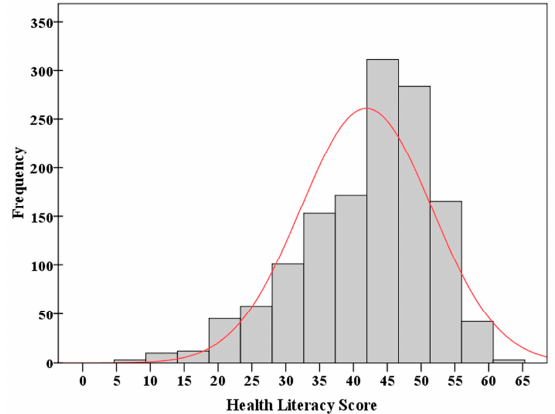
Figure 2. Histogram of the health literacy scores obtained from 1360 participants. The curve represents a normal curve with the mean and standard deviation estimated from the sample.